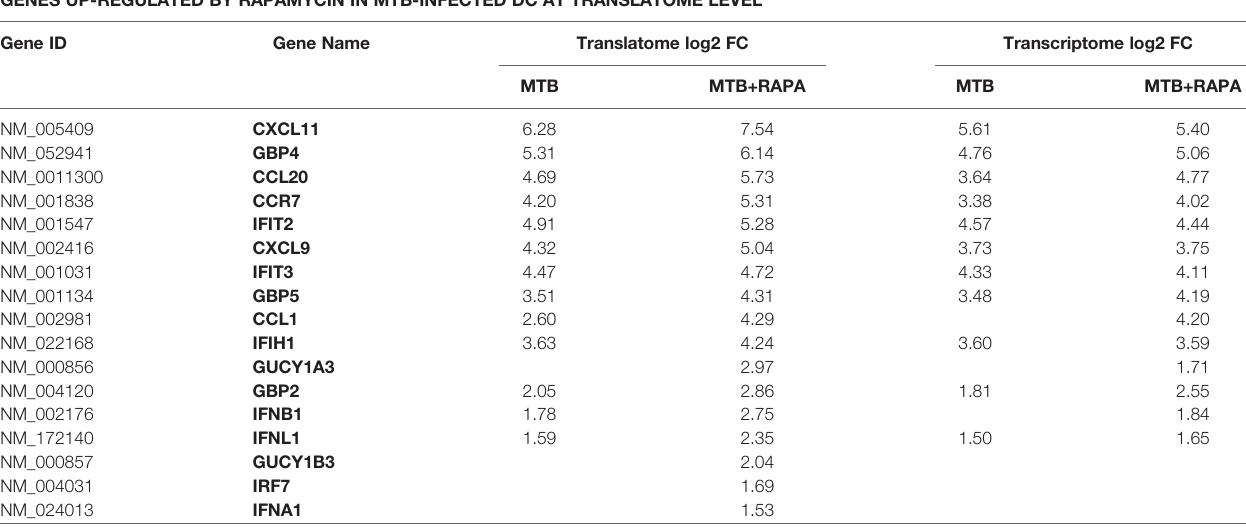
TABLE 1 | List of top genes de-regulated at the translatome level in human DC after Mtb infection and rapamycin treatment. GENES UP-REGULATED BY RAPAMYCIN IN MTB-INFECTED DC AT TRANSLATOME LEVEL Gene